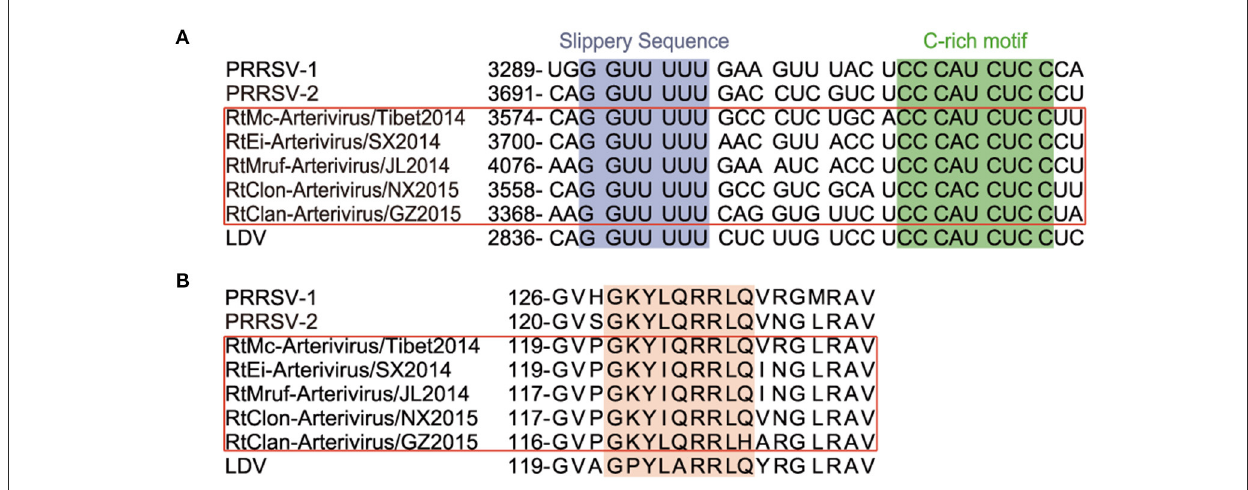
FIGURE2 − 2 PRF-related elements of arterivirus. The conserved “slippery sequence” and C-rich motif in nsp2 are highlighted in purple and green, respectively (A) , and the transactivated protein sequence in nsp1 β is highlighted in orange (B) .